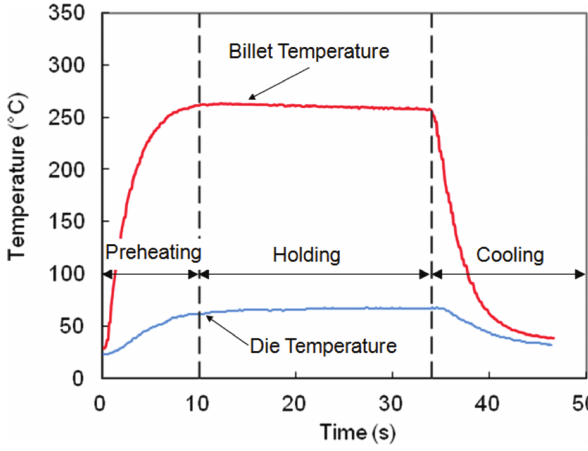
Figure 2: Time history of temperature in the resistance heating